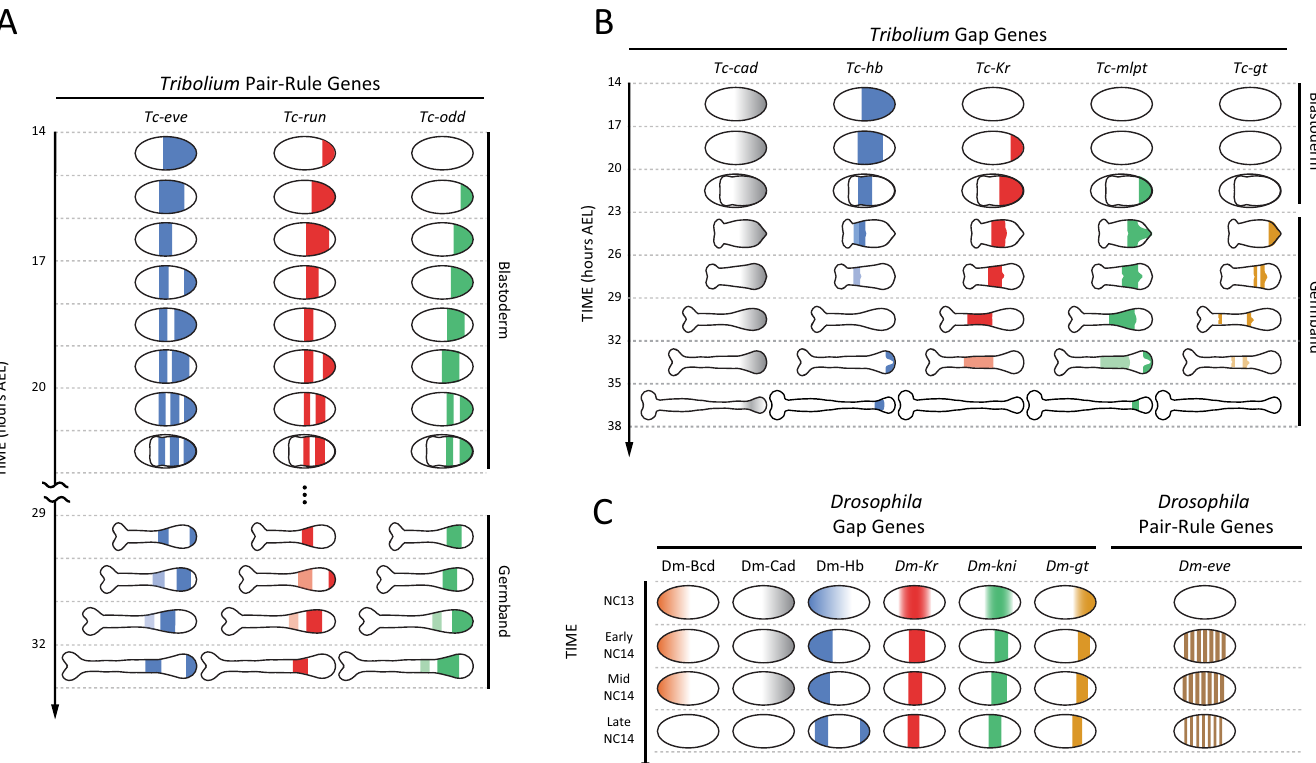
Fig 2. Key gene expression patterns during segmentation and regionalization in Tribolium (as a representative of short-germ insects) and Drosophila (as a representative of long-germ insects). (A) Expression patterns of segmentation clock genes in Tribolium (namely primary pair-rule genes: Tc-eve (shown in blue), Tc- run (red), and Tc-odd (green)) across time (at 24˚C) during both the blastoderm and germ-band stages of embryogenesis. Tribolium clock genes are expressed periodically as consecutive waves that propagate from posterior (right) to anterior (left) (frequency doubling of pair-rule gene expressions is not depicted). (B) Key regionalization gene expression patterns in Tribolium (namely gap genes: Tc-hb (blue), Tc-Kr (red), Tc-mlpt (green), and Tc-gt (gold)) across time (at 24˚C) during both blastoderm and germ-band stages of embryogenesis (head expressions of gap genes are not depicted for simplicity), in addition to Tc-cad (shown in gray), a master regulator of both segmentation and regionalization in Tribolium . Tribolium gap genes are expressed as consecutive nonperiodic waves that propagate from posterior (right) to anterior (left) within the expression domain of Tc-cad . (C) Expression patterns of selected Drosophila segmentation genes (namely the pair-rule gene Dm-eve (shown in brown)) and regionalization genes (namely the gap genes: Dm-Hb (blue), Dm-Kr (red), Dm-kni (green), and Dm-gt (gold)) across time during the blastoderm stage, in addition to master regulator gradients: Dm-Bcd (orange) and Dm-Cad (gray). Drosophila gap gene expression bands arise more or less simultaneously before nuclear cycle 14 (NC14). Later during NC14, pair-rule gene expressions arise, also more or less simultaneously. Eventually, expression domains of both gap and pair- rule genes undergo posterior-to-anterior shifts, reminiscent of the posterior-to-anterior propagation of gap and pair-rule gene expression waves in Tribolium . Finally, and concomitantly with the degradation of Dm-Bcd and Dm-Cad gradients, gap and pair-rule gene expression domains stabilize, pair-rule gene expressions undergo frequency doubling (not depicted), then both gap and pair-rule gene expressions eventually fade. Throughout the figure, for all embryo schematics: anterior to the left and posterior to the